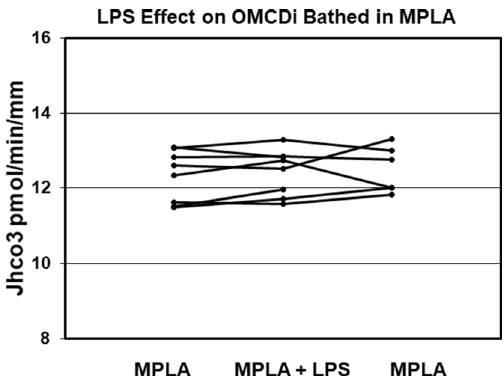
Figure 2. LPS added to the lumen at 500 ng/ml has no inhibitory effect on HCO 3 absorption by OMCDs from the inner stripe in the presence of 1 μg/ml MPLA in the bath (n = 6